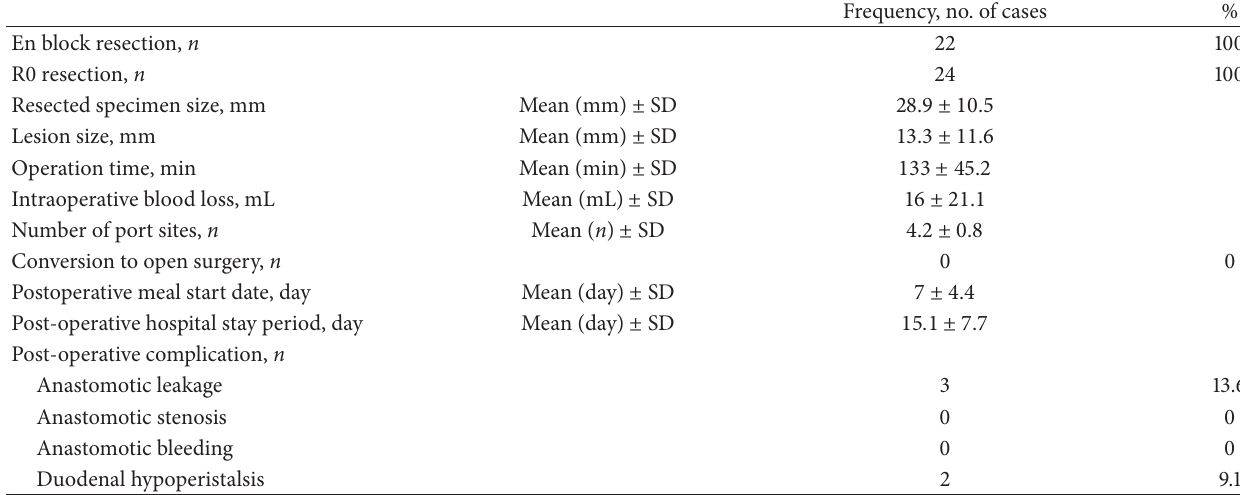
Table 3: Operative data for endoscopy-assisted laparoscopic full-thickness resection (EALFTR) for duodenal neoplasms.